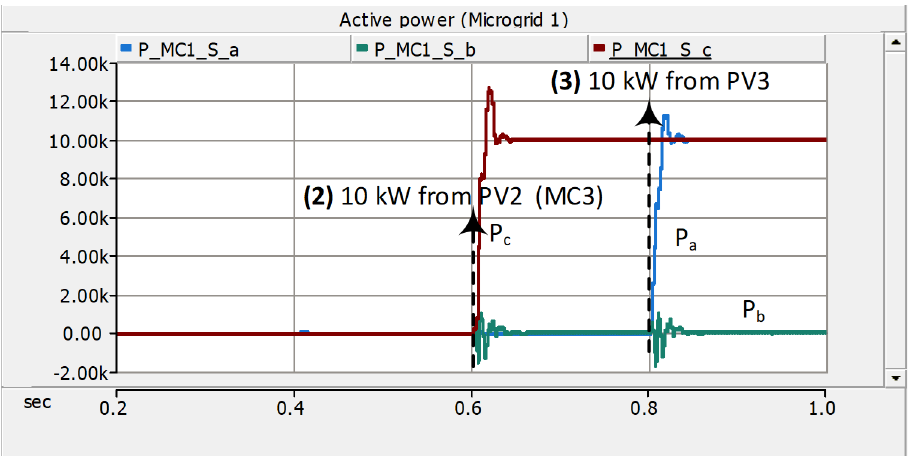
Figure 14. Active power across A-B winding at the delta side of T3. Active power injection to terminal A, B, and total power are labeled as P a , P b , P ab , respectively.